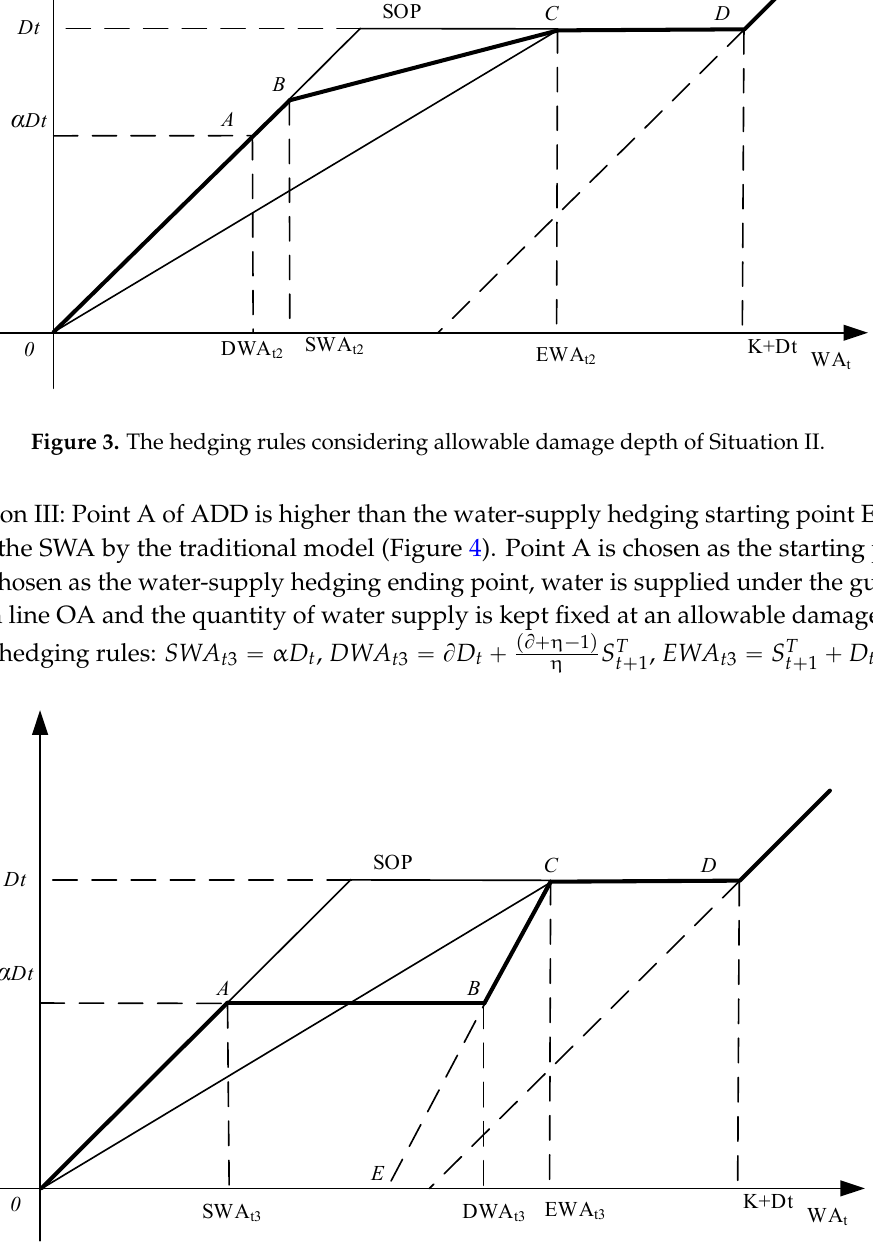
Figure 4. The hedging rules considering allowable damage depth of Situation III.